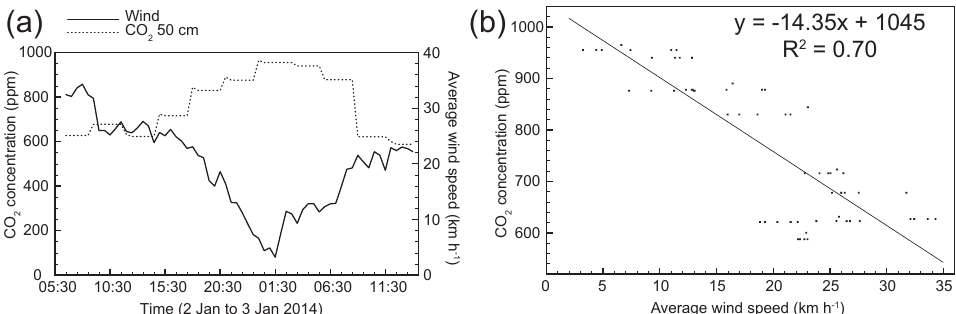
Figure 3. (a) Time series of wind speed and CO 2 concentration at 50cm above the ground within the snowpack from 06:30 on 2 January 2014 to 14:00 on 3 January 2014 at NM1. Average snow depth at NM1 over this time period was 124cm. (b) The corresponding linear regression of CO 2 concentration versus average wind speed ( R 2 = 0 . 70, P < 0 .